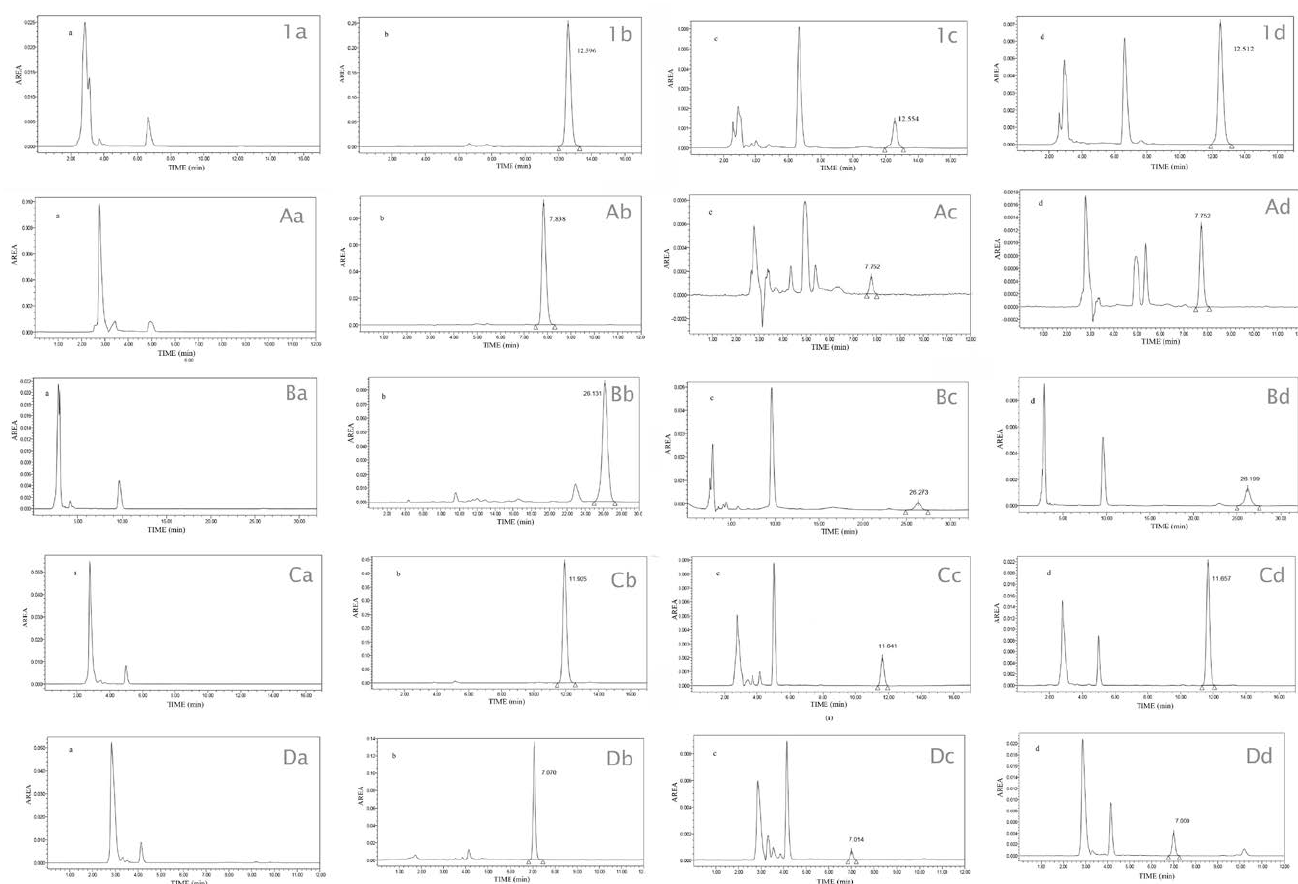
Figure 2. HPLC chromatograms of prenylated flavanones 1 , A – D classified with sub-index a, b, c, and d. a correspond to: Blank sample (ethanol: water, 70:30) permeated at chromatographic conditions of each prenylated flavanone; b correspond to prenylated flavanone standard; c correspond to prenylated flavanone from receptor compartment Franz di ff usion cells; and, d correspond to prenylated flavanone extracted from human skin after permeation